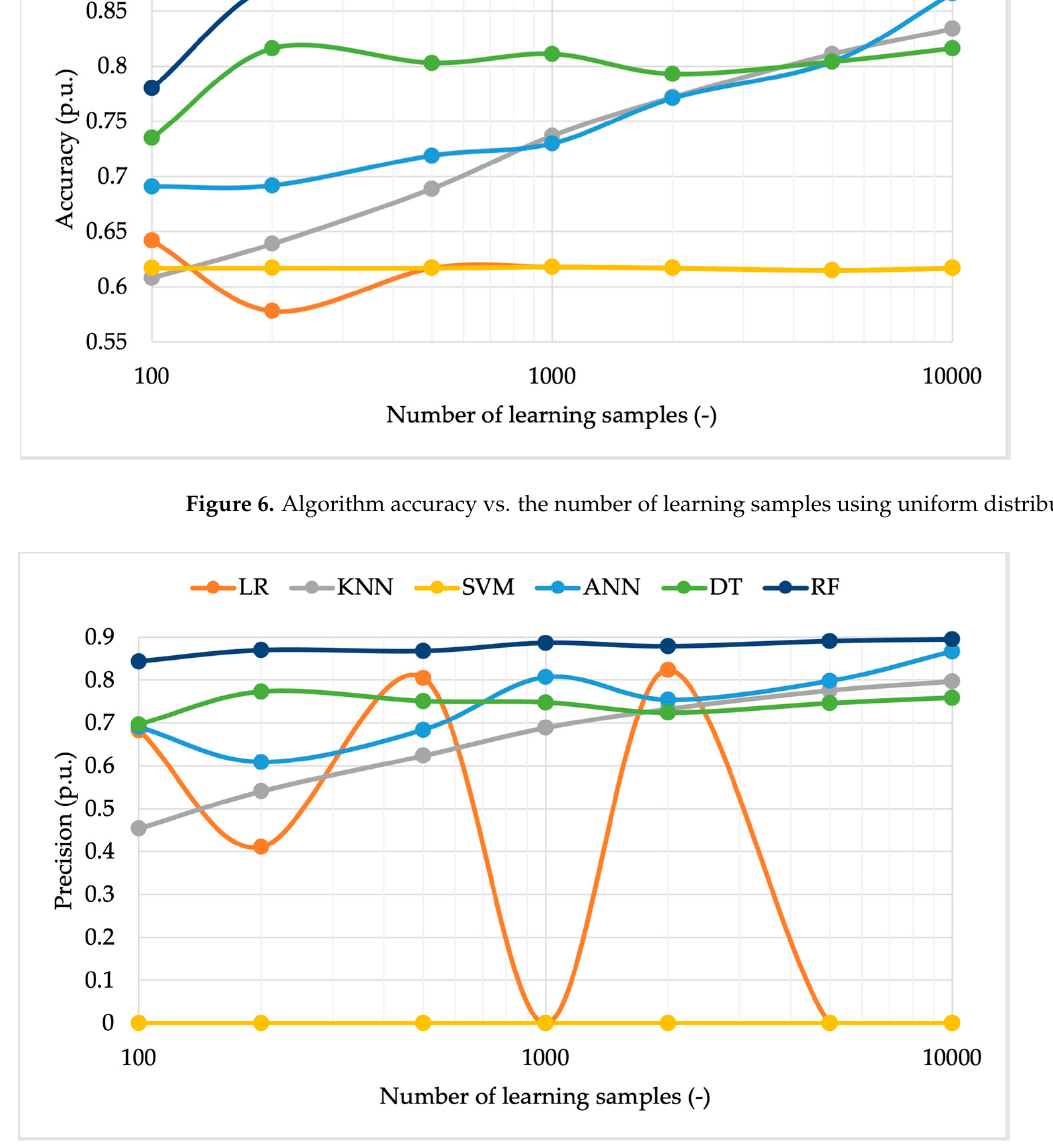
Figure 8. Algorithm recall vs. the number of learning samples using uniform distributed inputs. By relating precision and recall, it can be generally observed that, if the precision is zero, the recall must also be zero. Conversely, if the precision is not null, neither is the recall. Regarding the LR algorithm, when it has acceptable precision values, it has recall values close to zero. The explanation for this behavior is that the metric of precision has, in the denominator, the number of FP cases (a small number, since this algorithm almost always returns 0 as an output), while the metric of recall has the number of FN cases (a large number, for the same reason mentioned before). Evaluating the recall trend of the SVM, this is instead always null because the preci- sion of the algorithm has the same trend.